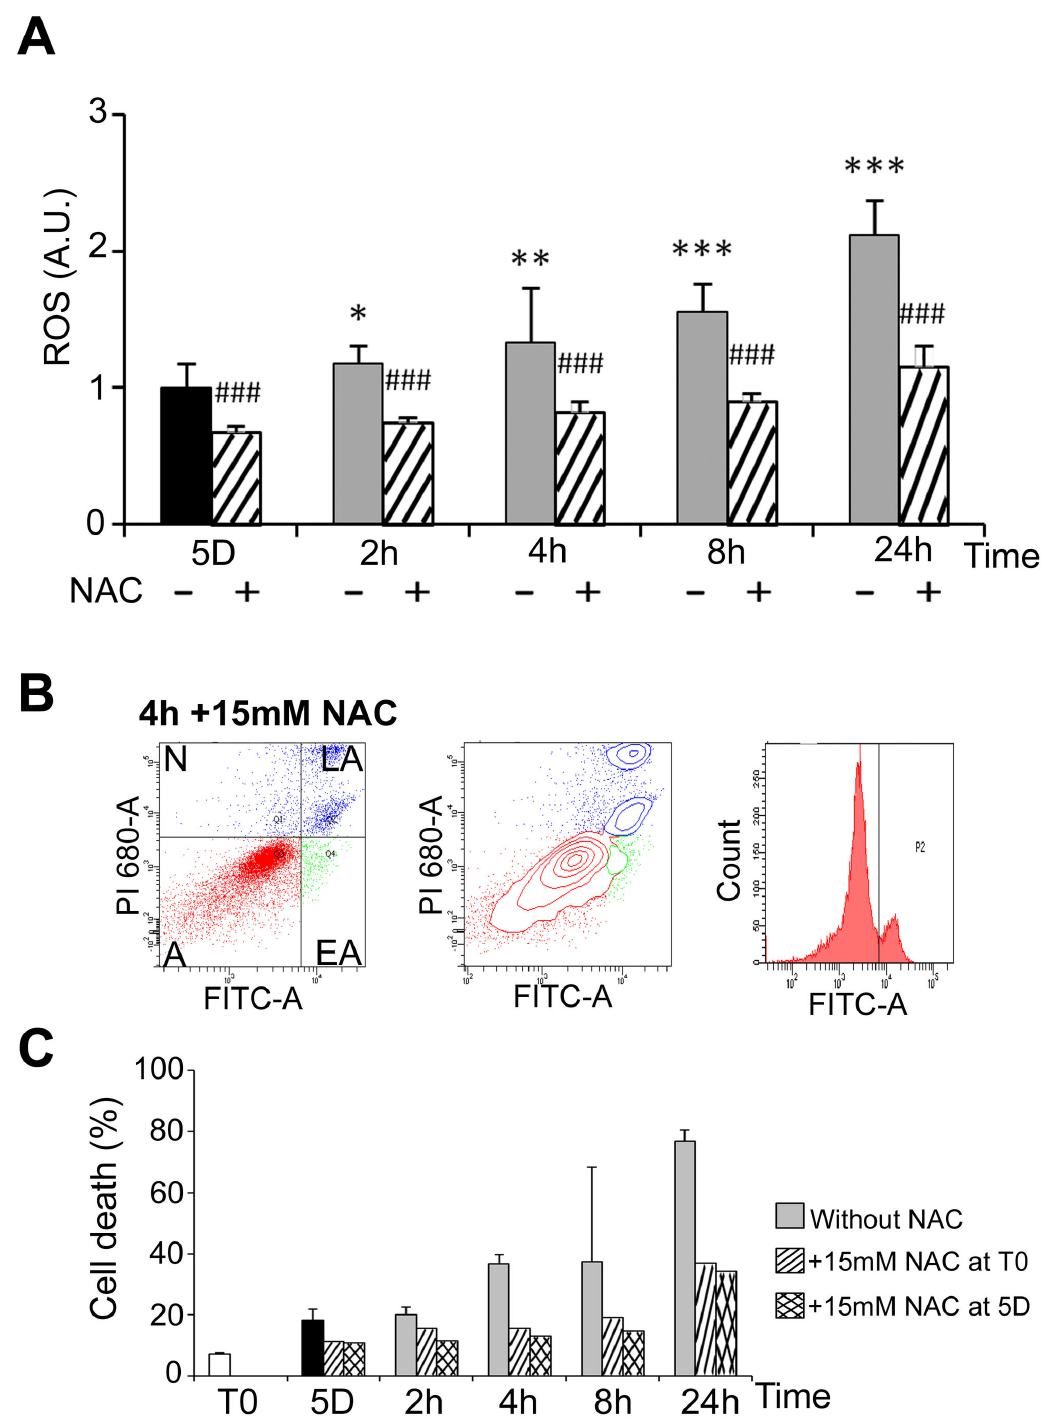
Figure 6. Rewarming-induced ROS production and ROS-dependant apoptosis. (A) ROS were measured in WI26 cells cultured at 25°C for 5 days and then warmed-up at 37°C for 2 to 24h in absence (-) and in presence (+) of 15mM N-Acetylcysteine (NAC). Data are expressed in arbitrary units taking T0 as 1. Significant inhibition by NAC versus condition without NAC is indicated # # # (p<0.001). (B) Cell viability was measured by FACS analysis after labeling with FITC-annexin V (FITC-A, X-axes) and propidium iodide (PI, Y-axes) of cells maintained 5 days at 25°C and then warmed-up at 37°C for 4h (4h) in the presence or in the absence of 15mM of NAC added at T0. (C) Percentage of apoptotic cells in the indicated culture conditions. doi: 10.1371/journal.pone.0069687.g006 PLOS ONE |